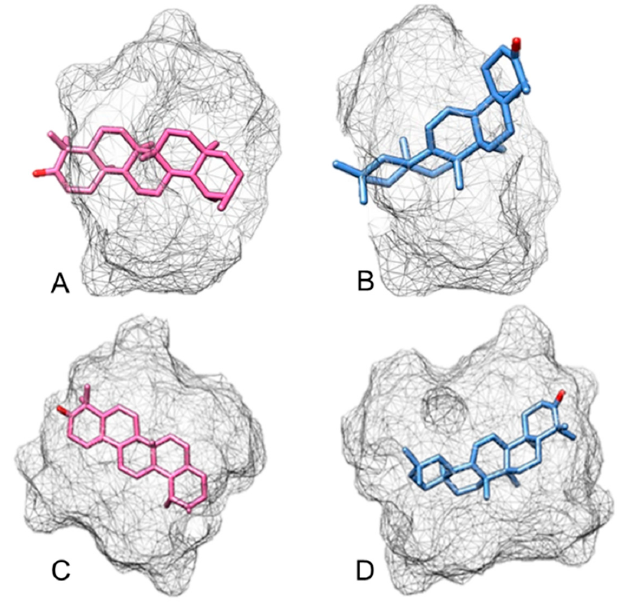
Figure 3. Energetic simulation of the interaction between α , β -amyrenone and β -cyclodextrin ( β CD) in the molar ratios of 1:1 ( A , B ) and 2:1 ( C , D ). ( A ) α -amyrenone: β CD, coupling with the face containing hydroxyl groups inside the β CD cavity, ( B ) β -amyrenone: β CD, coupling with the face containing the hydroxyl groups outside the β CD cavity, ( C ) α -amyrenone: β CD in complete coupling, ( D ) β -amyrenone: β CD, in complete coupling. Table 3. Computed average values of intermolecular interaction energy. Energy (kcal.mol − 1 ) Molar Ratio Type of Cyclodextrin − 40.24